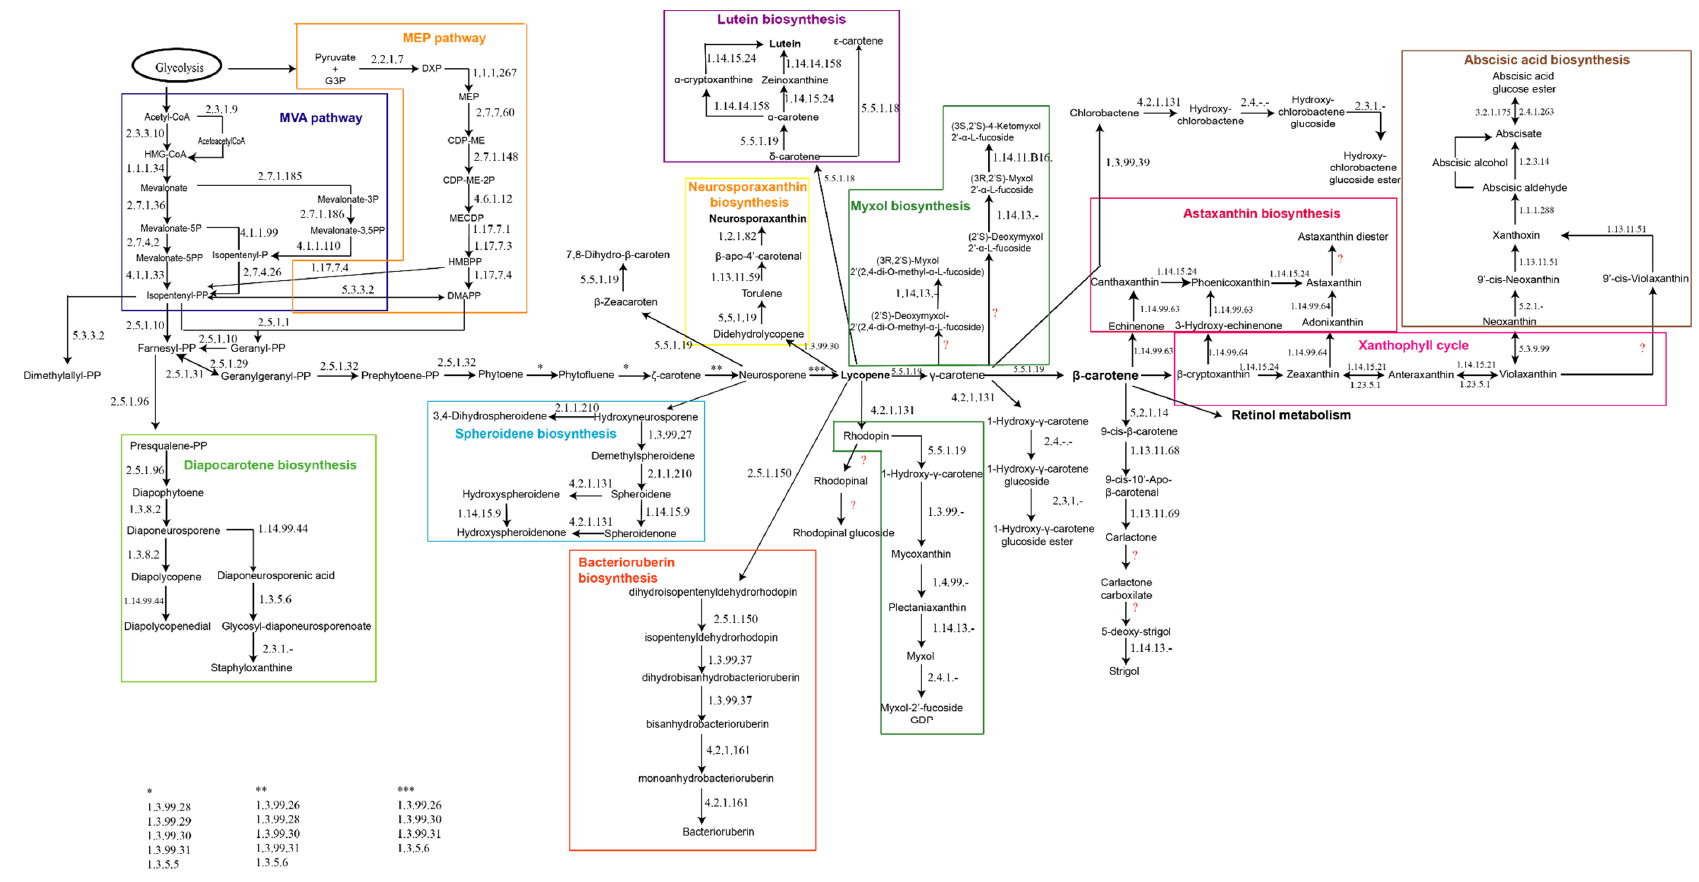
Figure 1. Metabolic map for global carotenogenesis. The enzymes catalyzing each reaction are indicated using their respective EC numbers (Enzyme commission numbers). Interrogation marks indicate unidentified enzymes.